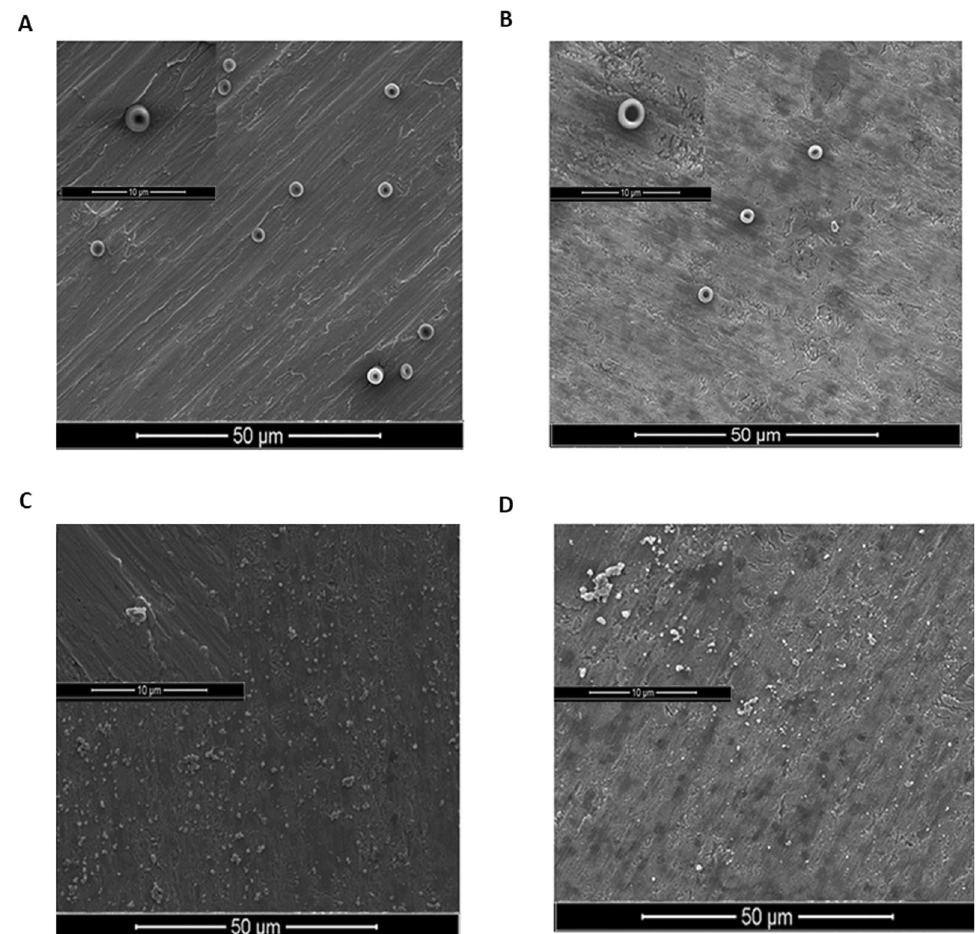
Fig. 7 FESEM characterization on blood and platelet activation. A RBC aggregation on the surface of TI, B RBC aggregation on TNA, C Platelet activation on Ti surface, and D platelet activation on the TNA surface. The FESEM image was captured at magnification 2000 also10,000 (10 ×